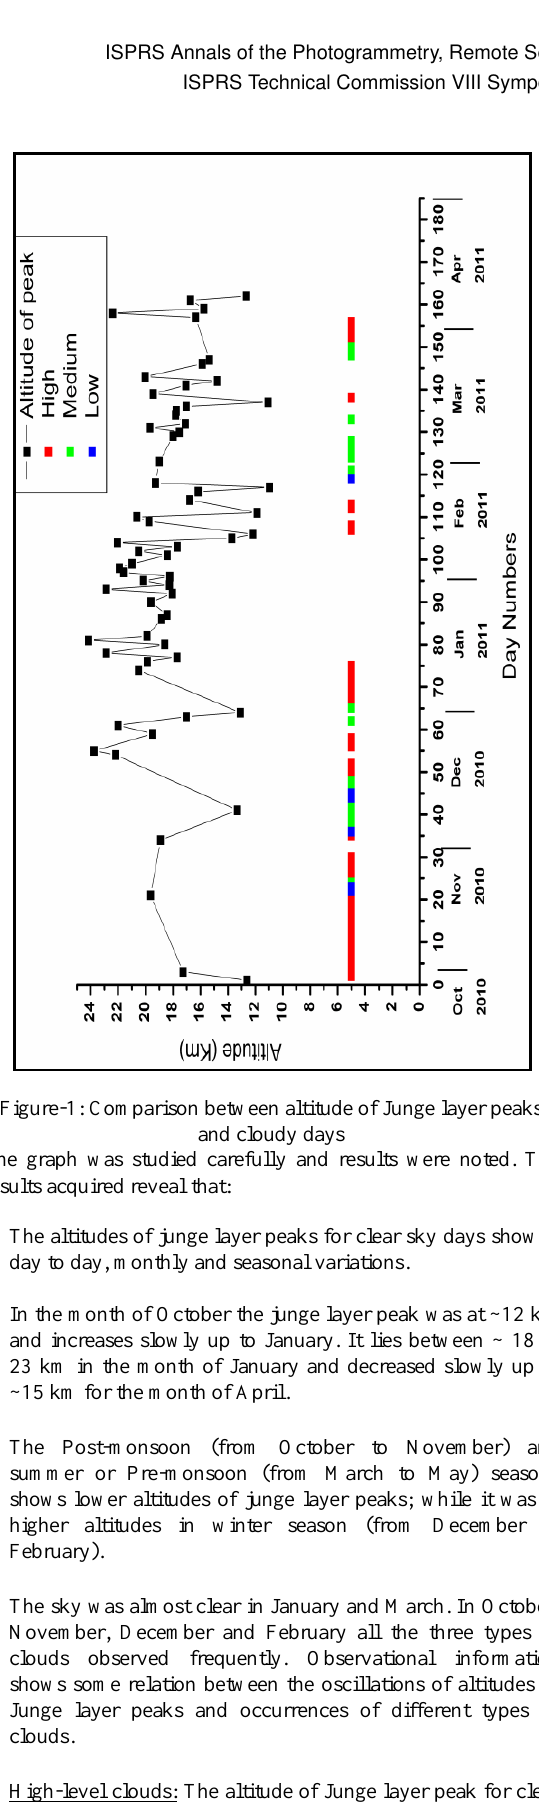
Figure-2: Comparison between AND of Junge layer peaks and cloudy